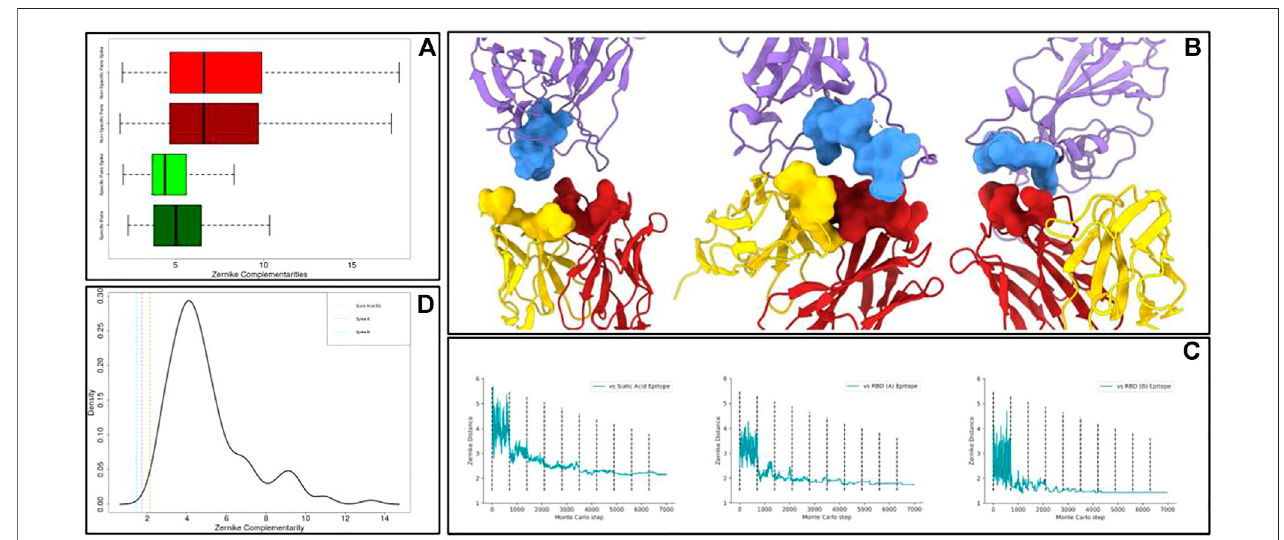
FIGURE 3 | Application of the optimization protocol to the SARS-CoV-2 spike protein. (A) Boxplots comparing the speci fi c complementarity and the non-speci fi c complementarity ingenericprotein – antibodyorinspike – antibodycomplexes.Itisworthremarkingthatwhenthenumericalvalueislow,thecomplementarityishigh. (B) Molecularrepresentationoftheoptimizedantibodiesbindingepitopesonthespikeprotein.Theantibodylightandheavychainsareshowninyellowandredrespectively, whilethe antigenisinpurple. (C) Shape complementarity asafunctionoftheMonte Carlostepsforall theantibodies weoptimized. Dashed lines separate different temperature intervals of the simulations. (D) Probability density function of speci fi c complementarities in the Spike dataset. The dashed lines represent the shape complementarity levels reached after the optimization